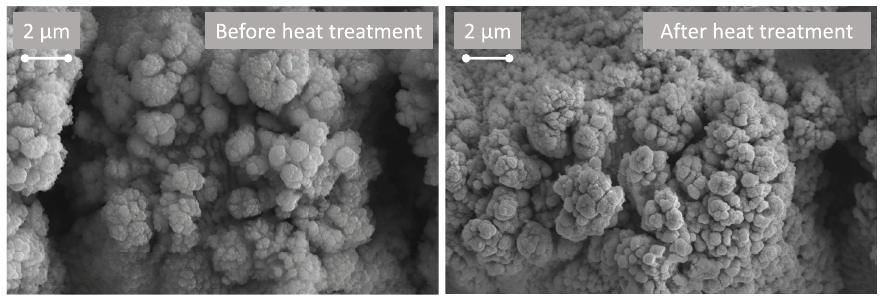
FIG. 5. SEM images of the sample after heat treatment compared to a similar reference sample before heat